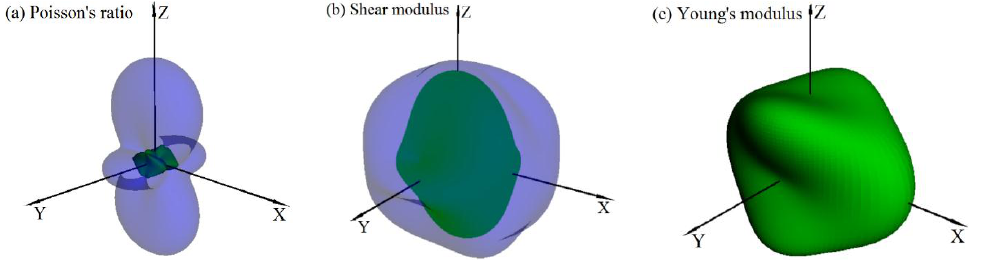
Figure 5. The surface construction of Poisson’s ratio ( a ); shear modulus ( b ); and Young’s modulus ( c ) for the Pnma -BN.